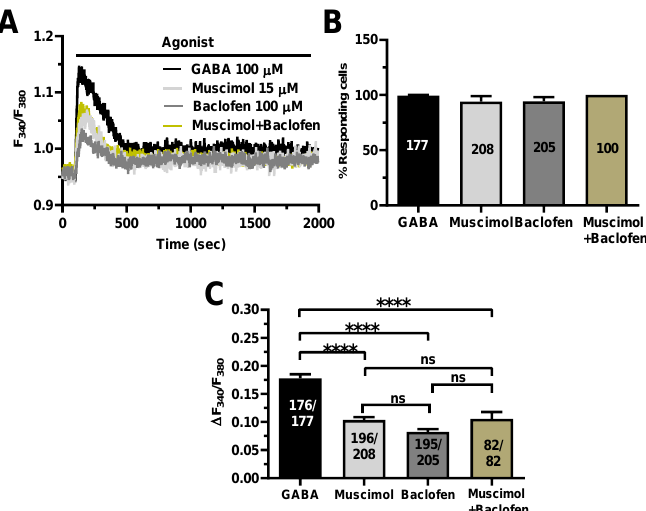
Figure 6. Selective stimulation of GABA A and GABA B receptors induce intracellular Ca 2+ signals in hCMEC/D3 cells. ( A ), representative tracings of the biphasic Ca 2+ signals induced by GABA (100 µM), the GABA A receptor agonist, muscimol (15 µM), the GABA B receptor agonist, baclofen (100 µM), and muscimol (15 µM) + baclofen (100 µM), in hCMEC/D3 cells. ( B ), mean ± SE of the percentage of hCMEC/D3 cells responding to GABA, muscimol and baclofen. ( C ), mean ± SE of the amplitude of the peak Ca 2+ response to GABA, muscimol and baclofen. **** indicate p < 0.0001 (one-way ANOVA followed by the post-hoc Bonferroni test). NS indicates not